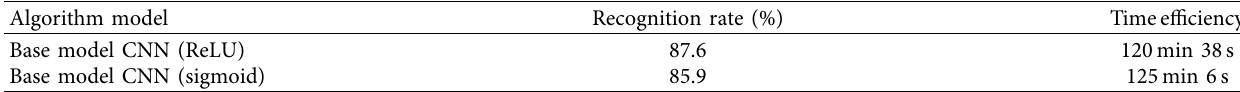
Figure 5: ReLU function model. Table 1: Recognition rate and time efficiency under the basic model.